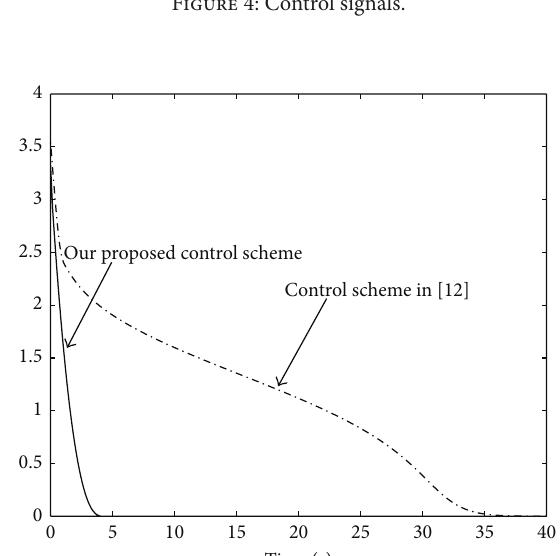
Figure 2: The position of the robot.